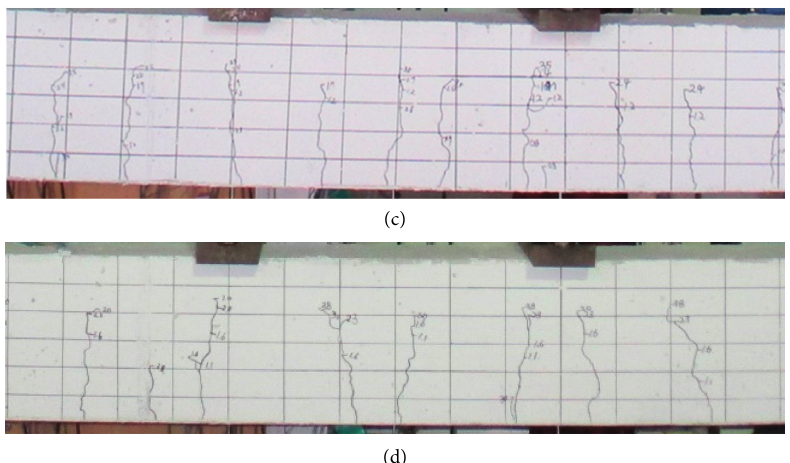
Figure 6: Typical crack patterns at the service load stage ( P � 0.6 P R050-S1. (d) Beam R100-S1.